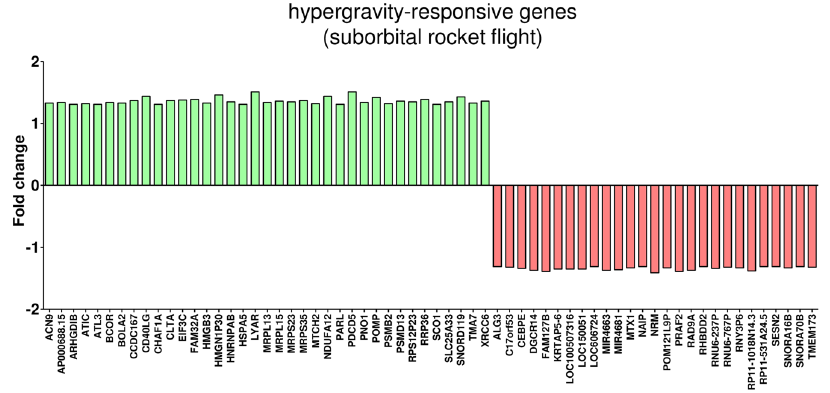
Figure 8. Hypergravity-responsive gene expression (suborbital rocket flight). Exposure of Jurkat T cells to hypergravity during the rocket launch of the TEXUS-51 sounding rocket led to 37 up and 27 down-regulated genes when compared to the 1 g in-flight control (log2 values, p < 0.05).